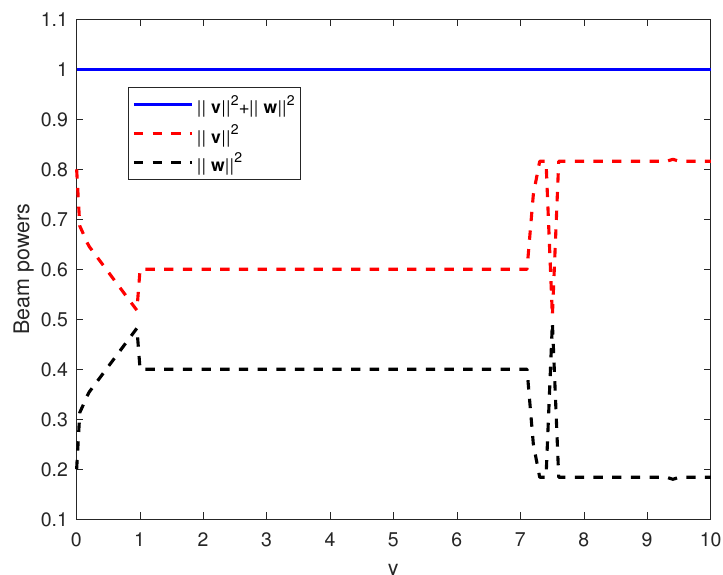
Figure 7. Beam powers after optimization via Task